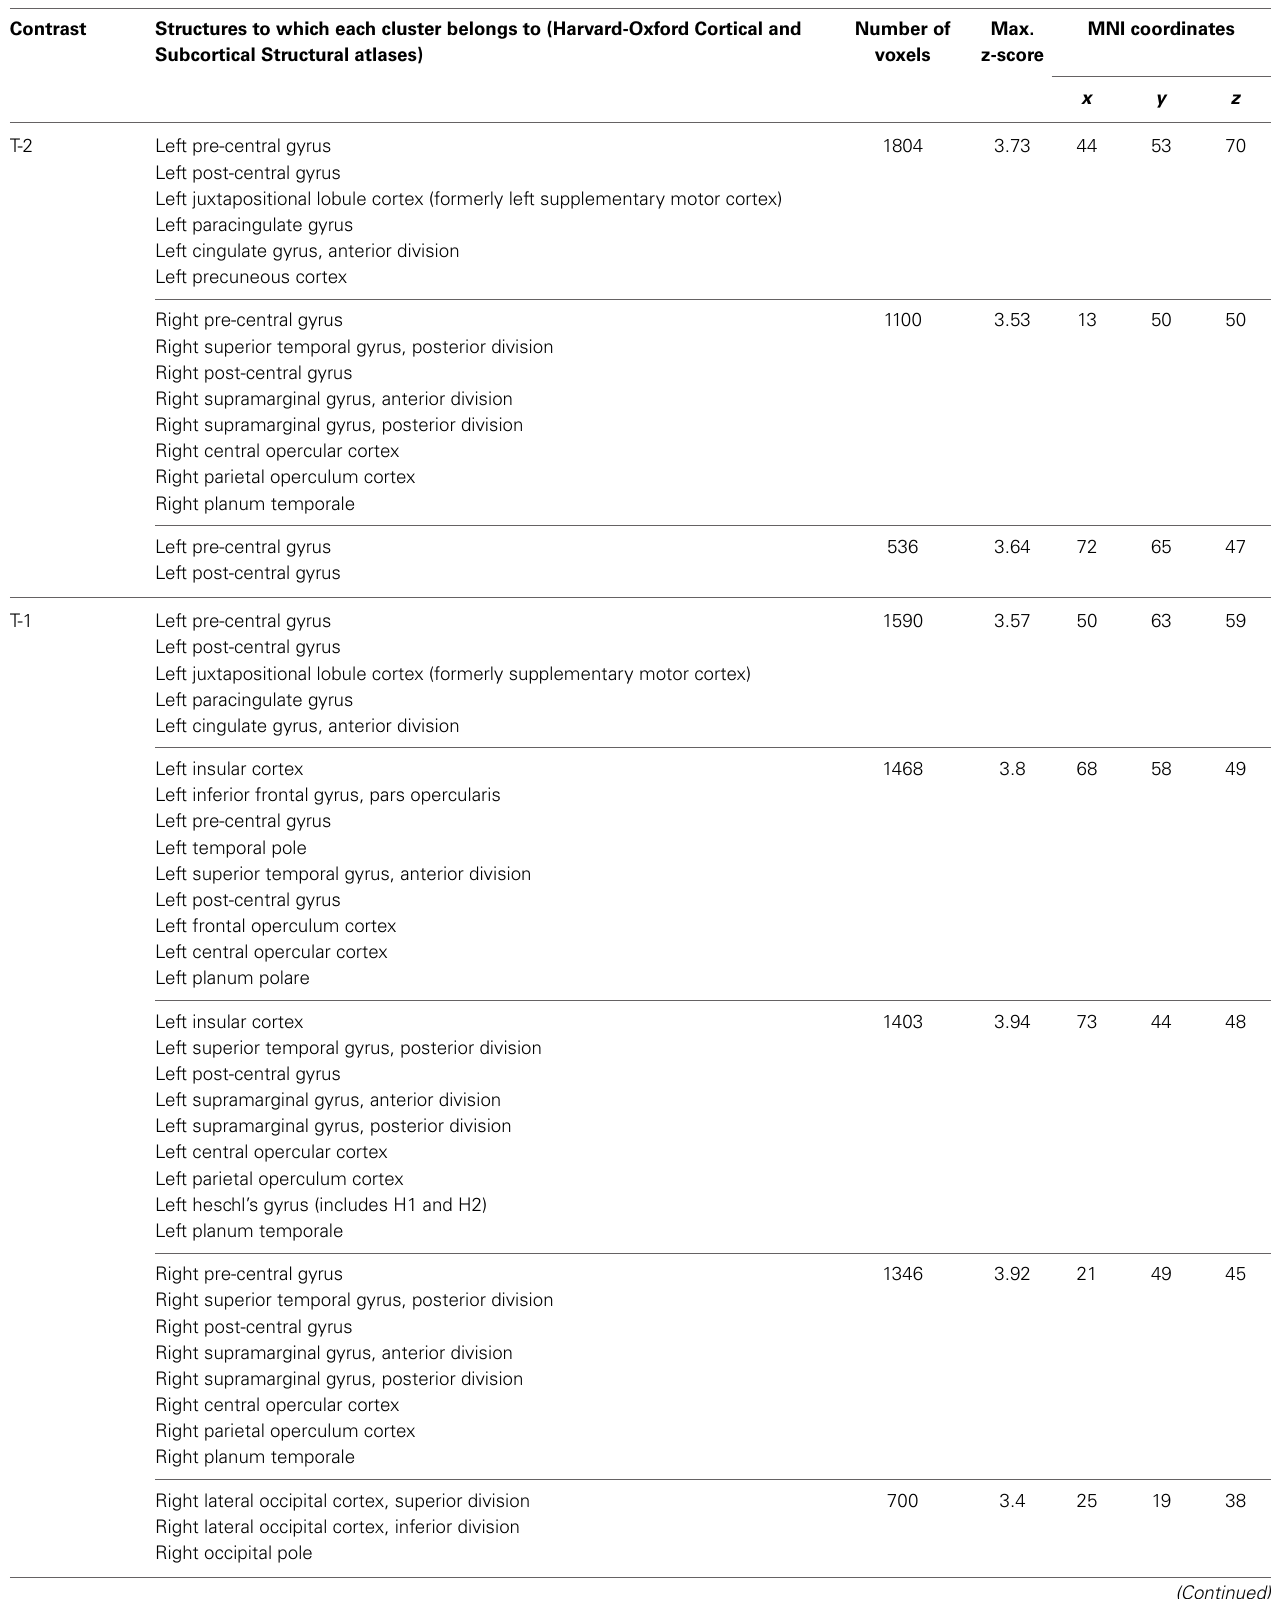
Table 2 | MNI coordinates of clusters with maximal z-scores in the fMRI data analysis of tics in the Tourette sample. Contrast Structures to which each cluster belongs to (Harvard-Oxford Cortical and Subcortical Structural atlases)